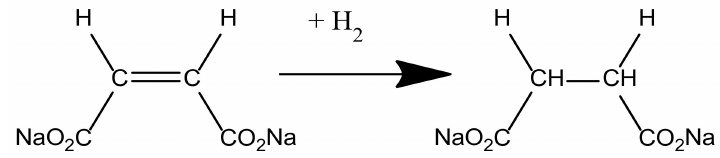
Figure 9. Sodium maleate reduction reaction scheme.